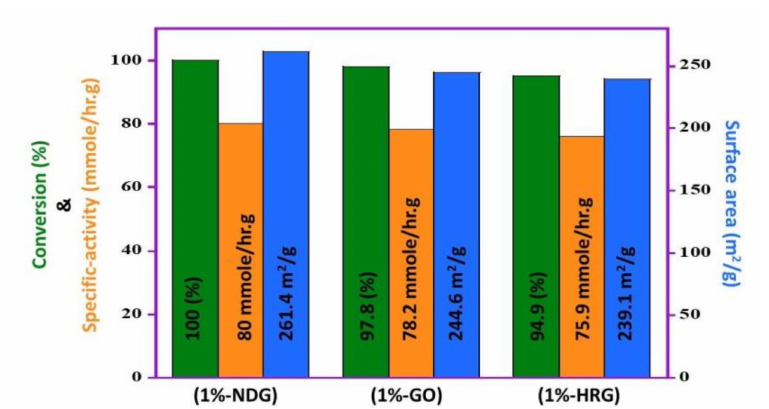
Figure 9. Comparative illustration of effect of various graphene-based dopants in the catalytic system on its catalytic